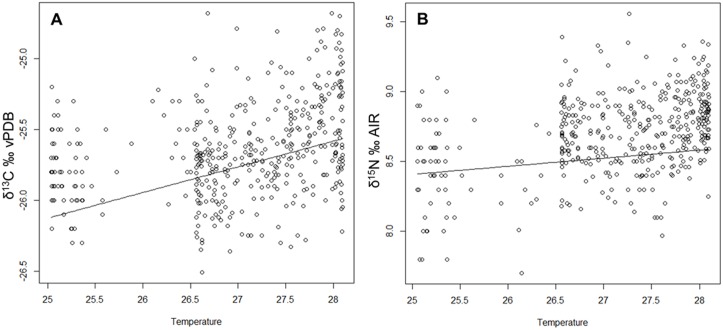
GLMM model results suggested significant increases in δ13C (A) and δ15N (B) values with increase in temperature (°C), representing season.This isotopic increase is more pronounced in δ13C values than in δ15N values.